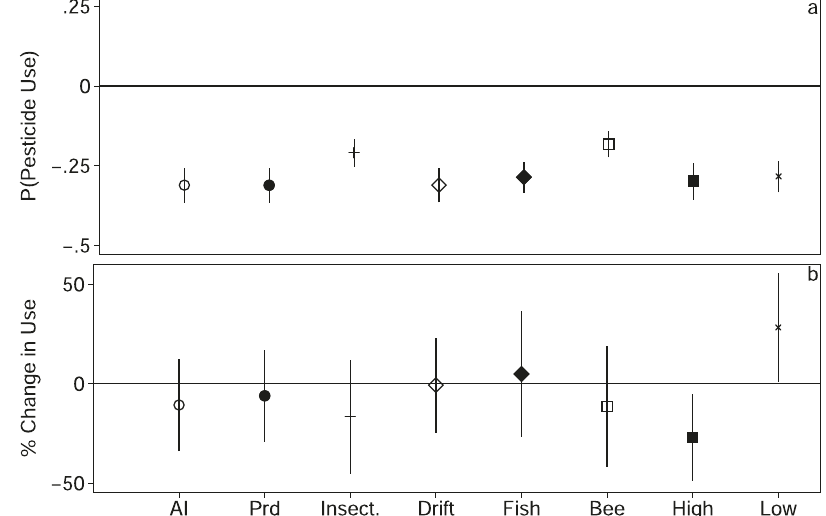
Fig. 2 Lognormal hurdle models for different pesticide use outcomes. Lognormal hurdle models estimating the change in the probability of pesticide use ( a ) and the percent change in pesticide use for fi elds with positive use ( b ) for organic relative to conventional fi elds. The x -axis indicates different measures of pesticide use outcomes: kg ha − 1 active ingredients (AI), kg ha − 1 products (Prd), kg ha − 1 of products targeting insect pests only (Insect), kg ha − 1 of products with a propensity to drift (Drift), kg ha − 1 products of potential hazard to fi sh and bees (Fish, Bee), as well as products of higher (EPA signal word 1 – 2) and lower (EPA signal word 3 – 4) acute human toxicity (High, Low). Across all outcomes, organic fi elds have a signi fi cantly lower probability of using pesticides ( a ), though there is little difference between organic and conventional fi elds for those that do spray, with the exception of higher and lower toxicity chemicals ( b ). Symbols indicate point estimates (mean) and error bars represent the 95% CI. All models include cluster robust standard errors clustered at the farm-by-crop family level. For the second hurdle ( b ) in Figs. 2 – 4, percent change is calculated from the log-level model as 100 ð e β (cid:2) 1 Þ and standard errors are derived using the delta-method implemented with the nlcom function in Stata. All models include covariates for fi eld size, farm size, and soil quality as well farm-by-crop family random effects. N = 91,926 for all speci fi cations in the fi rst hurdle ( a ) and N = 68,704 (AI), N = 68,816 (Prd), N = 52,606 (Insect.), N = 67,988 (Drift), N = 60,653 (Fish), N = 48,254 (Bee), N = 61,883 (High), and N = 65,593 (Low) in the second hurdle ( b ),